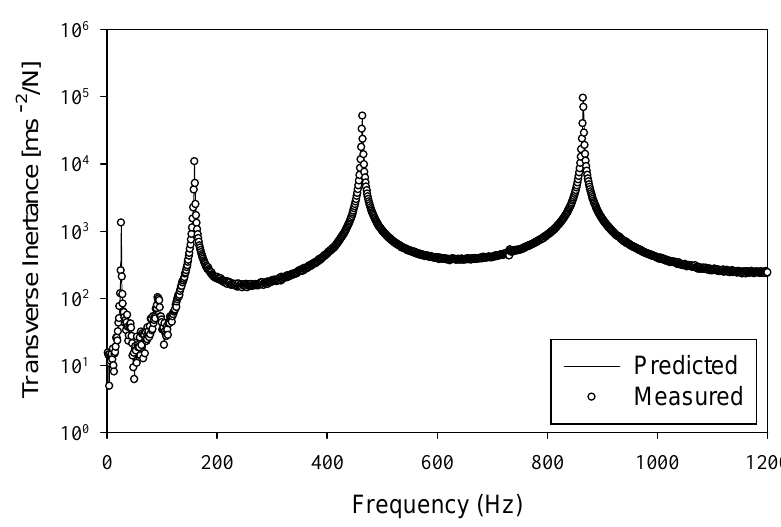
Fig. 11. Comparison of the measured and predicted transverse inertance FRF at node 4 of the cantilevered beam with a bolt joint.